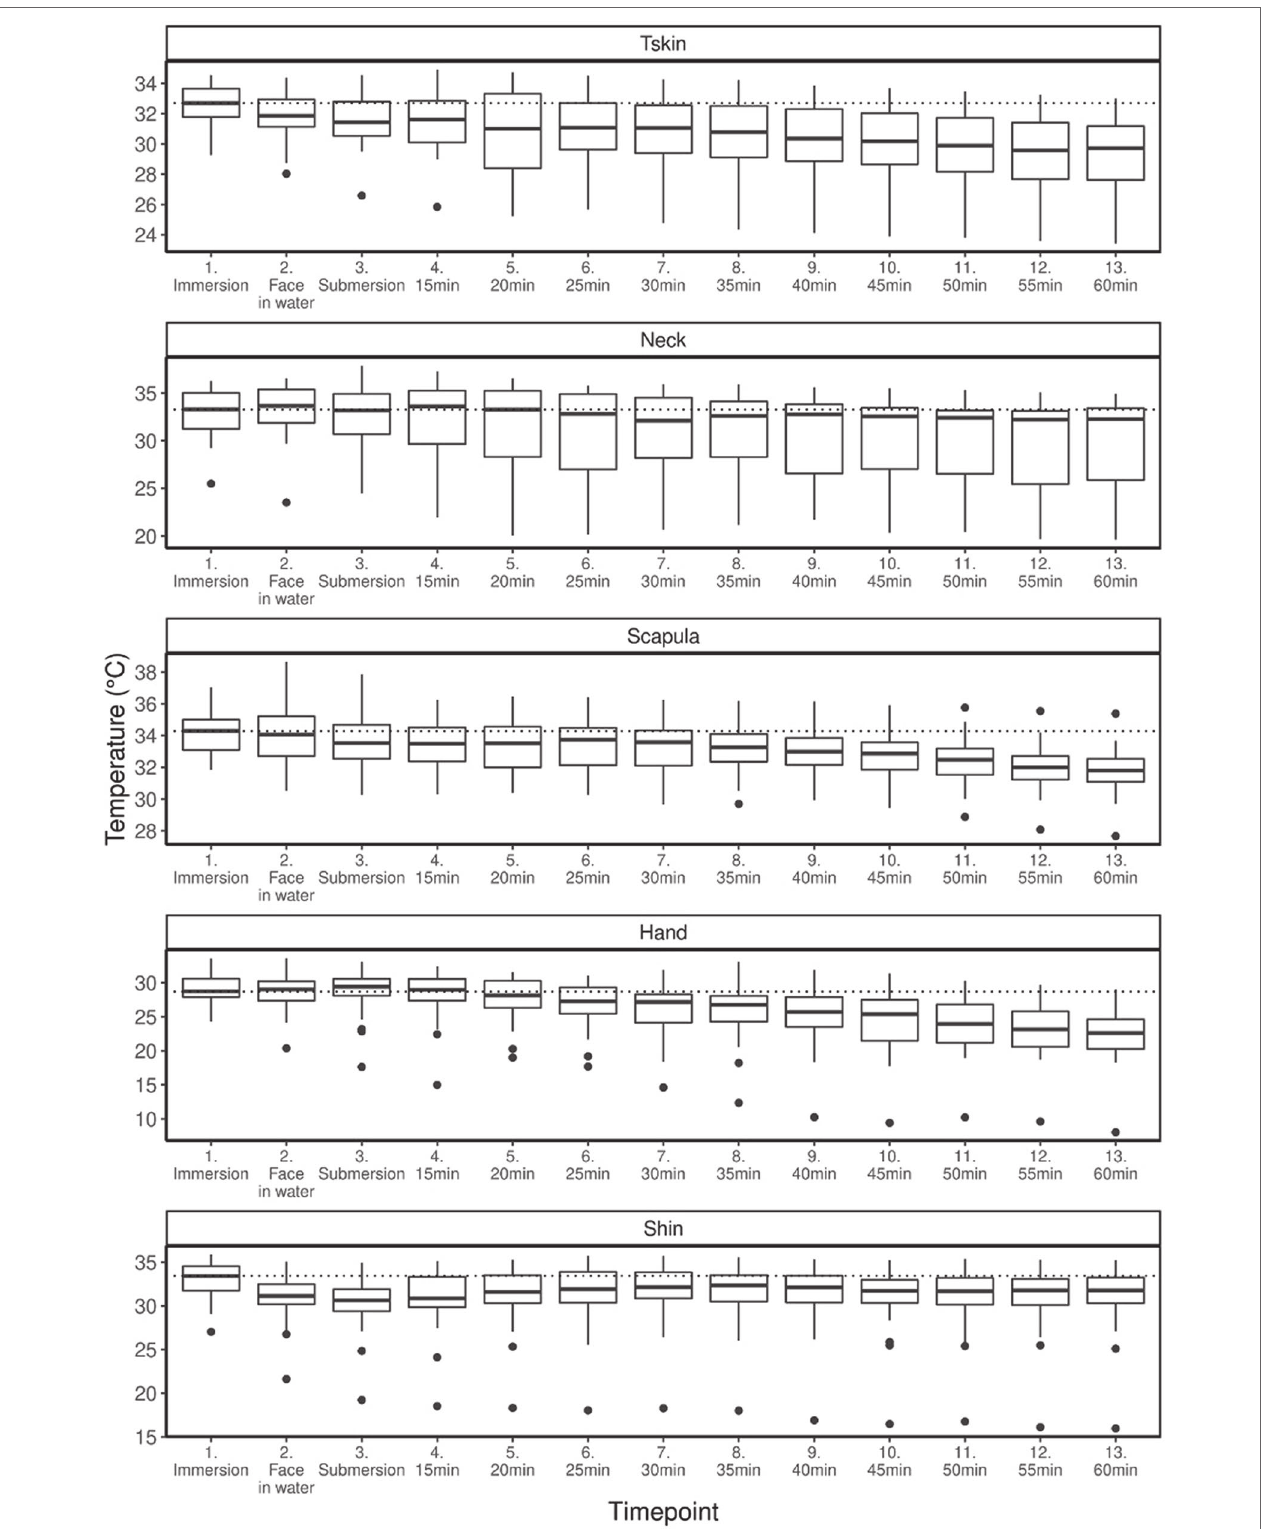
FIGURE 4 | The linear regression model of temperature measurements from immersion, when the divers put their faces into the water, when the divers submersed and from that point onward in 5-min intervals. There was a statistically significant ( p < 0.001) drop in temperature in all locations of